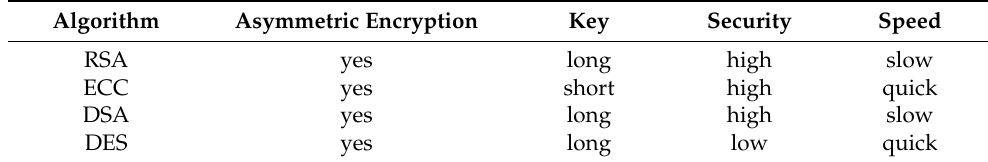
Table 1. Comparison of common encryption algorithms.